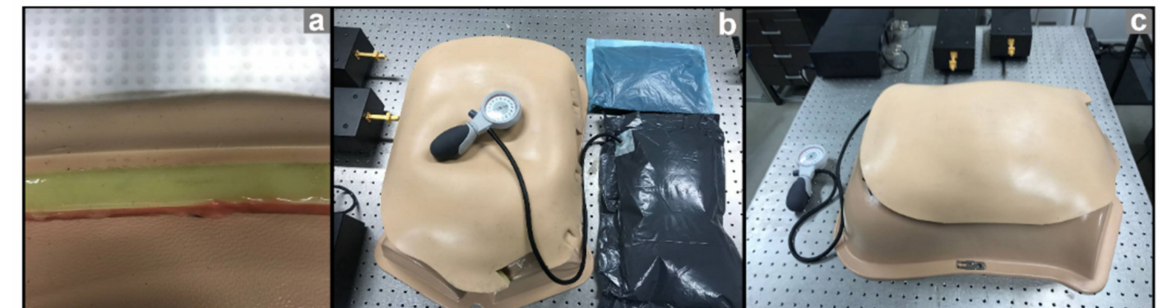
Figure 1. Abdominal wall phantom used in the in vitro study. ( a ) The multi-layer structure of the artificial abdominal wall, representing skin, fat, muscles, fascia, and peritoneum. ( b ) Artificial abdominal compartment in addition to water- and air-filled balloon to simulate different case scenarios in intra-abdominal hypertension. IAV was increased via the air-filled balloon, which subsequently resulted in intra-abdominal pressure (IAP) elevation. ( c ) The final assembly of the abdominal wall phantom studied by transient radar method (TRM).